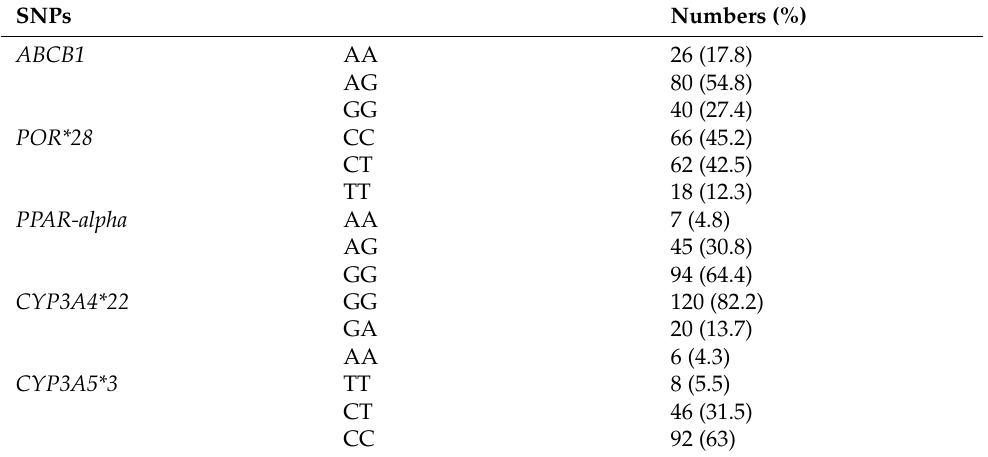
Table 3. Distribution of SNPs in the study